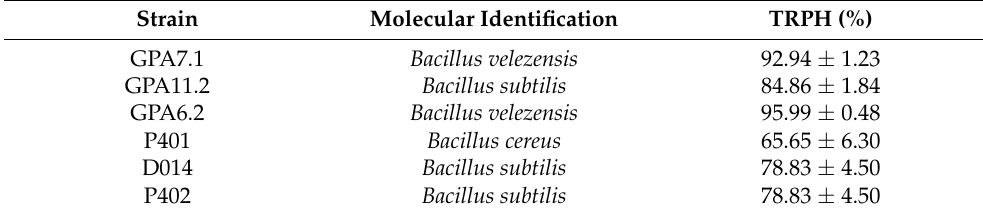
Table 1. Molecular identification of strains and TRPH degradation (%) after 16